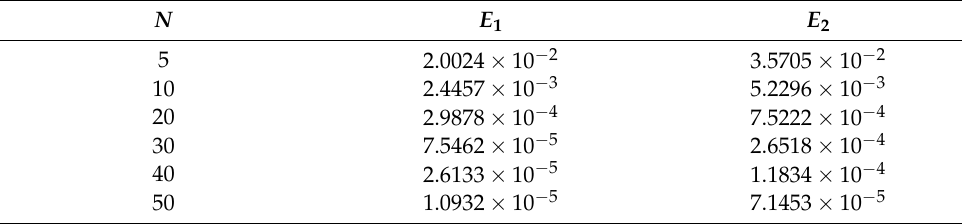
Table 4. Computed relative error estimations for Example 3 from some values of N